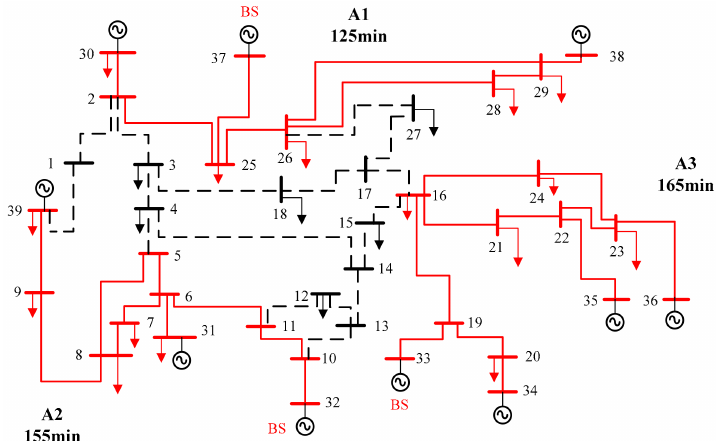
Figure 4. Initial skeleton bus points for group A1, A2 and